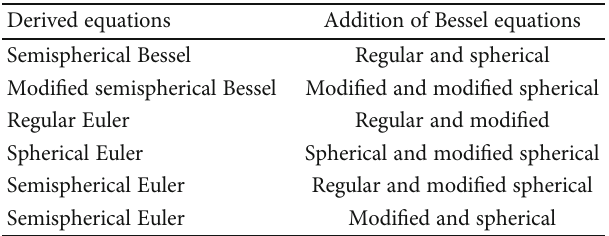
Table 2: Derivation of novel Bessel and Euler